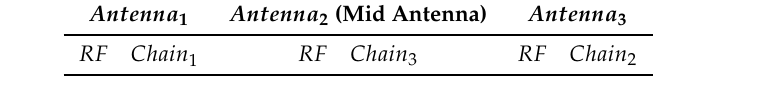
Algorithm 1 The fast phase calibration algorithm.